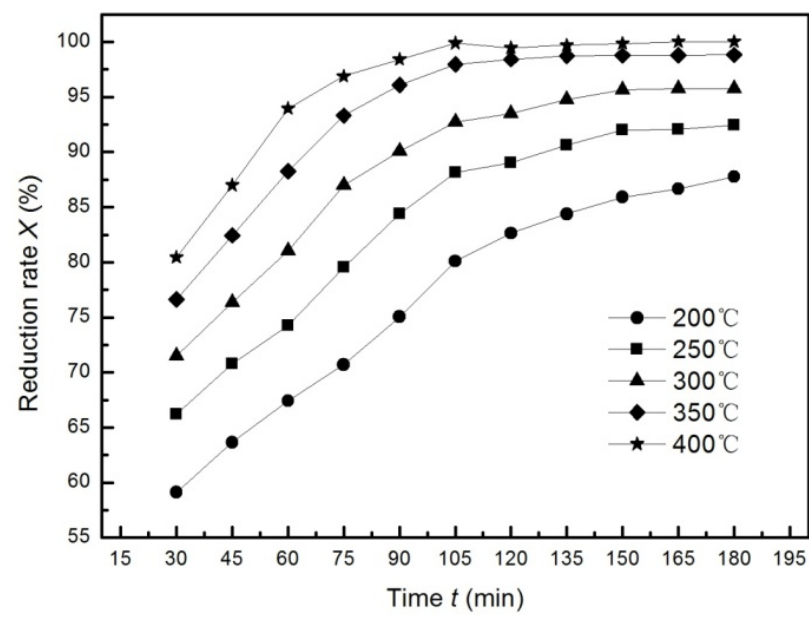
Figure 3. Effects of temperature and time on the reduction rate.